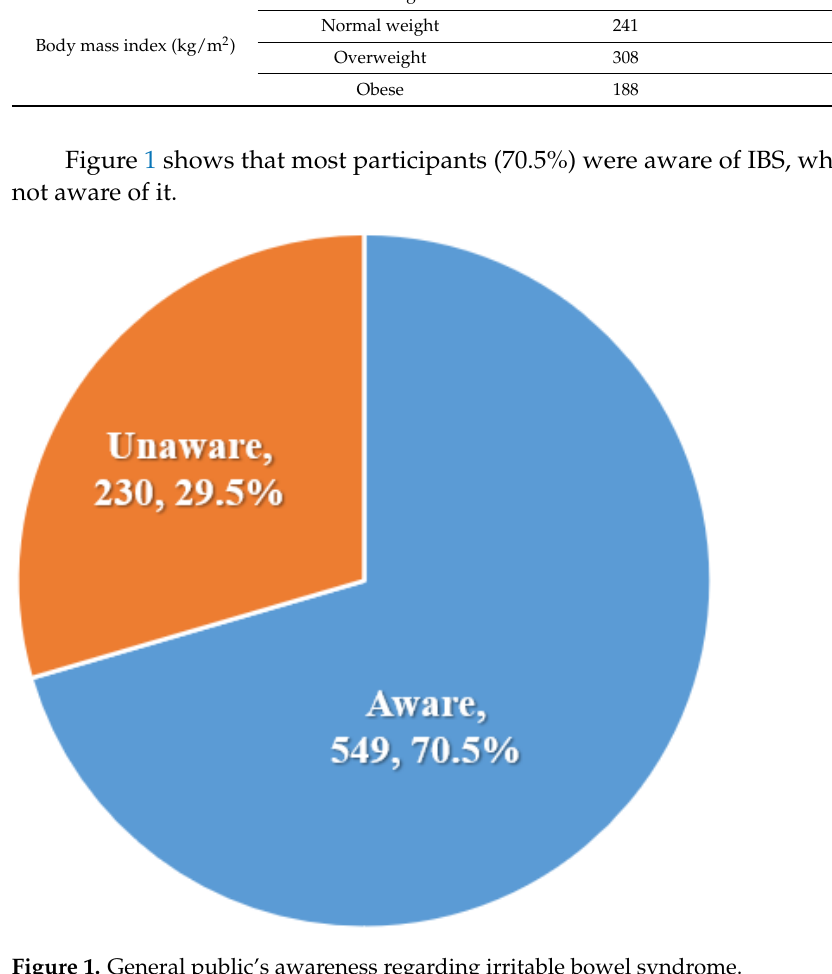
Figure 1. General public’s awareness regarding irritable bowel syndrome.